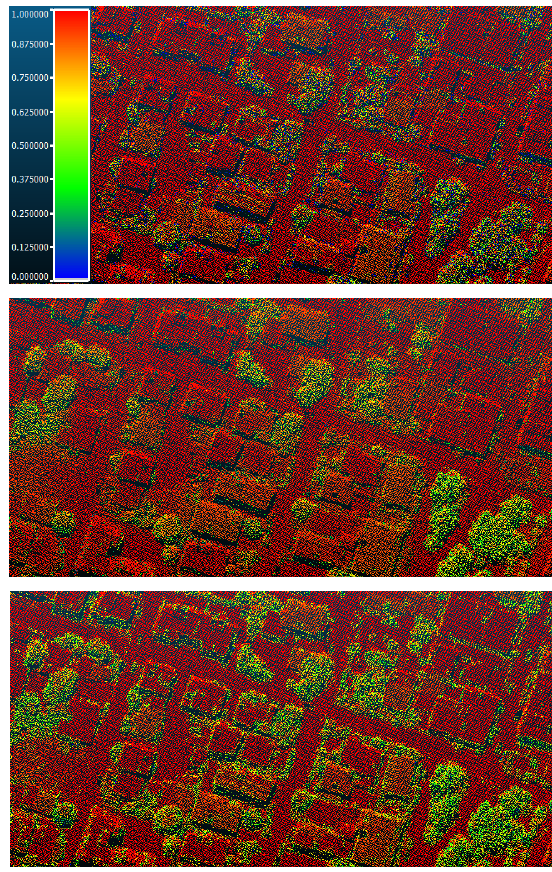
Figure 2. The LIDAR point cloud coloured by the initial N z values (top); the filtered N z values by the bilateral (middle) and the scan line smooth filtering (bottom).